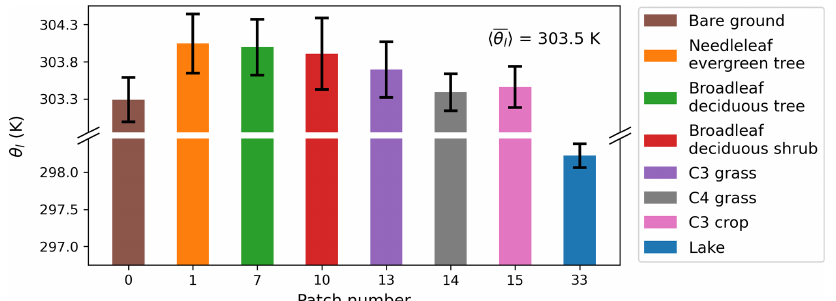
Figure 1. A schematic diagram illustrating the spatial heterogeneity in the grid cell (snapshot at 14:00LT on 2 June 2015). The vertical bars denote patch-mean liquid water potential temperature θ l for different patch types shown in colors (grid cell mean is 303.5K), along with the error bars indicating the MOST-based standard deviation of θ l and surface states and fluxes are both considered in heterogeneous coupling parameterization.